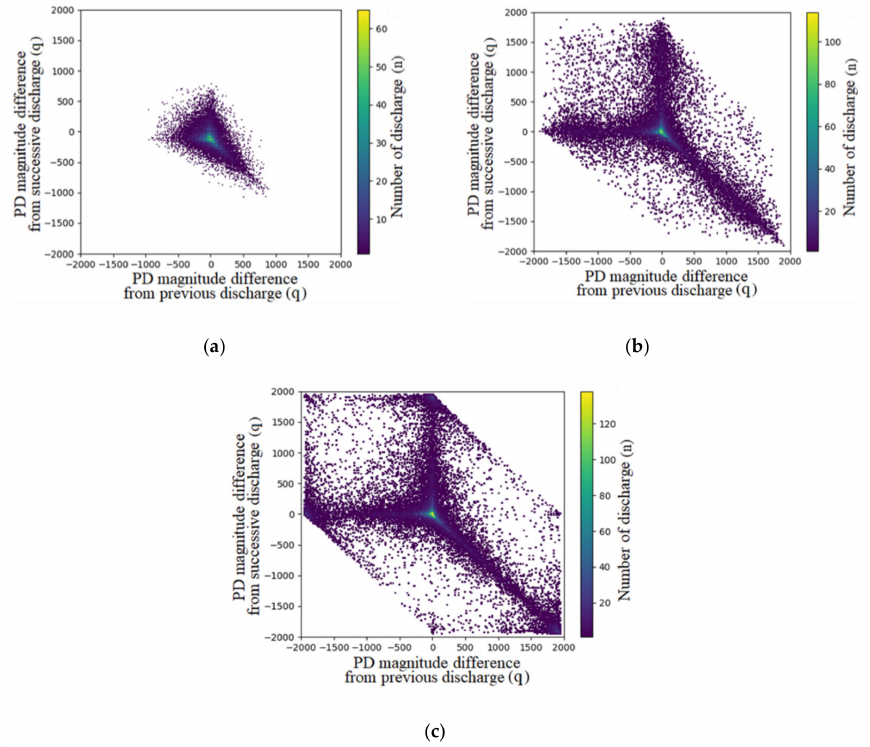
Figure 10. DC void discharge patterns according to the long-term insulation aging: ( a ) section of initial discharge occurrence; ( b ) section of the beginning of insulation aging; ( c ) period before the dielectric breakdown.